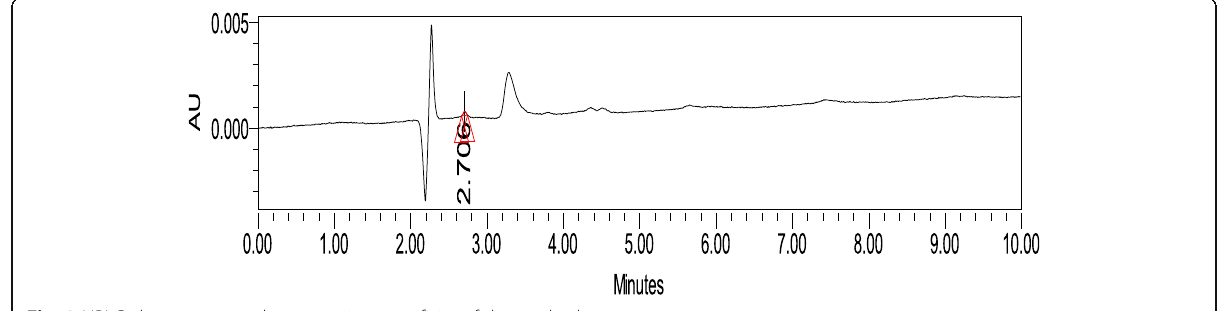
Fig. 3 HPLC chromatogram demonstrating specificity of the